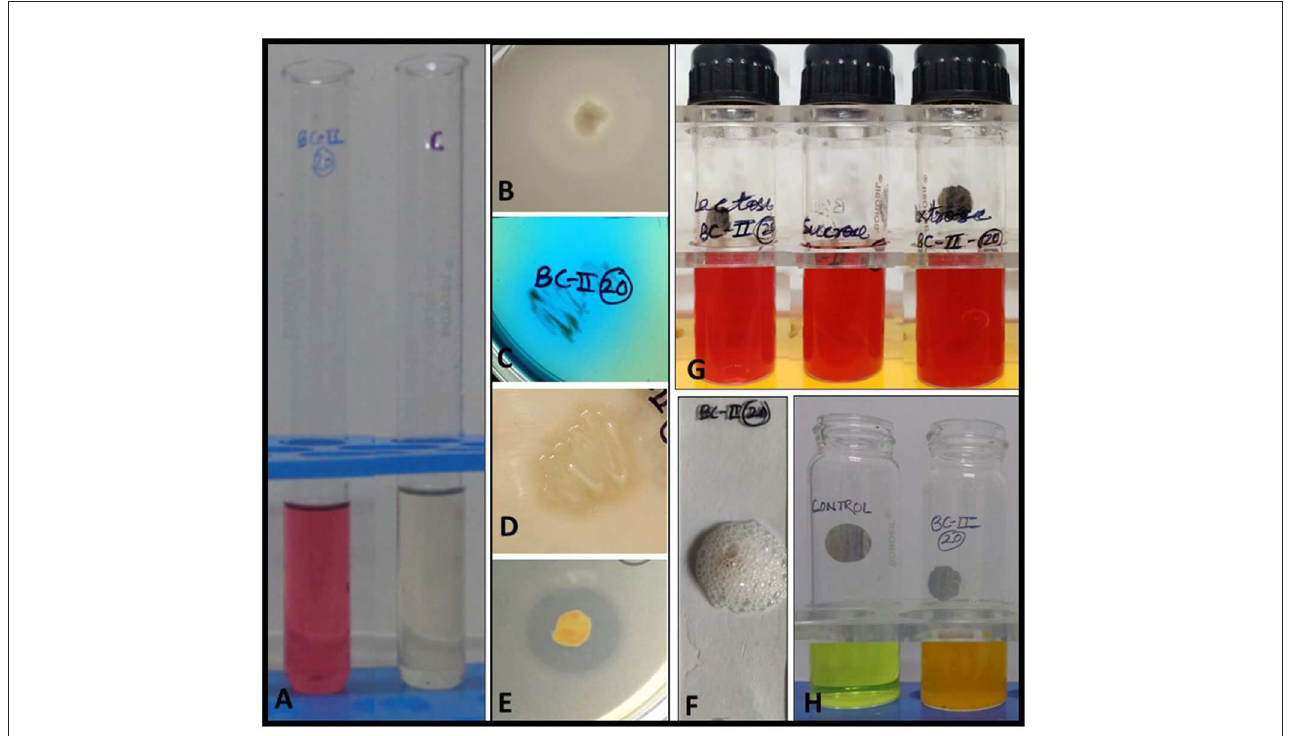
FIGURE1 In vitro biochemical and plant growth-promoting traits of bacterial isolate BC-II-20. (A) IAA production, (B) phosphate solubilization, (C) citrate utilization, (D) protease production, (E) calcite solubilization, (F) catalase test, (G) carbohydrate fermentation tests, and (H) ammonia production.